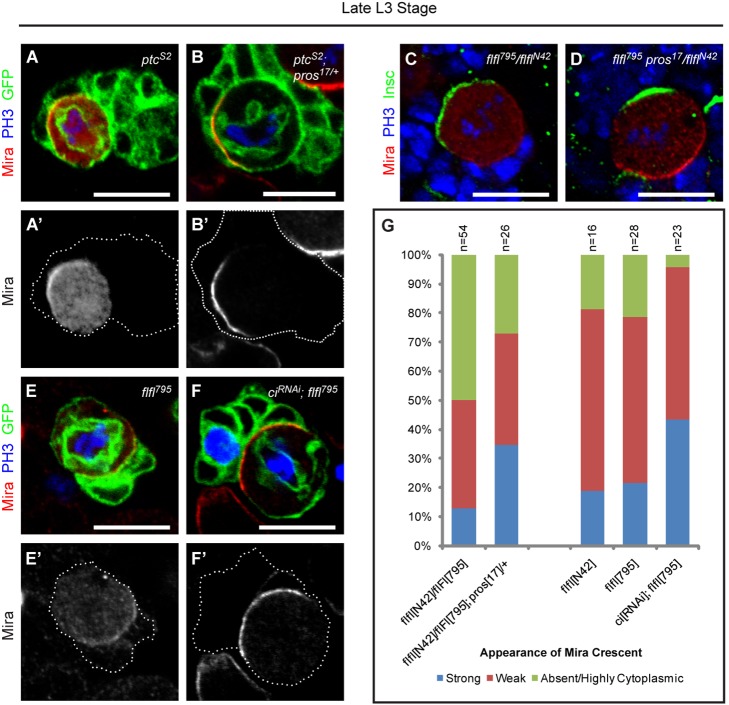
Hh signaling acts as a functional link between the temporal cascade and the asymmetric division machinery.(A–B′) The excessive cytoplasmic Mira and weak Mira crescent seen in ptcS2 NB during mitosis (A–A′) can be rescued by removing one copy of pros (B–B′). (C–D) Similarly, the excessive cytoplasmic Mira and weak Mira crescent seen in flfl795/flflN42 transheterozygous NB (C) can be rescued by removing a copy of pros (D). (E–F′) A flfl795 NB showing weak Mira crescent and cytoplasmic Mira (E–E′). Such Mira localization defects can be rescued via the introduction of ciRNAi. (G) Quantification of Mira localization phenotypes in various mutant backgrounds.